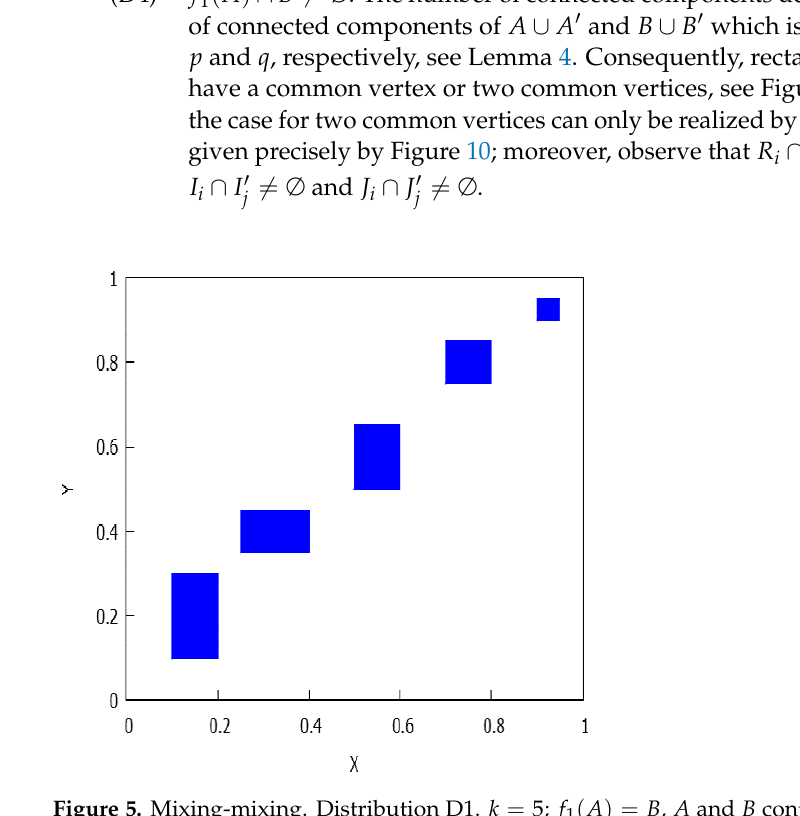
Figure 5. Mixing-mixing. Distribution D1. k = 5; f 1 ( A ) = B , A and B contain 5 disjoint intervals, that is, p = q = 5; k = (cid:96) = lcm ( 5,5 ) = 5. Observe that p 1 ( I ) = 1 and p 2 ( J ) = 1 for each rectangle R = I × J